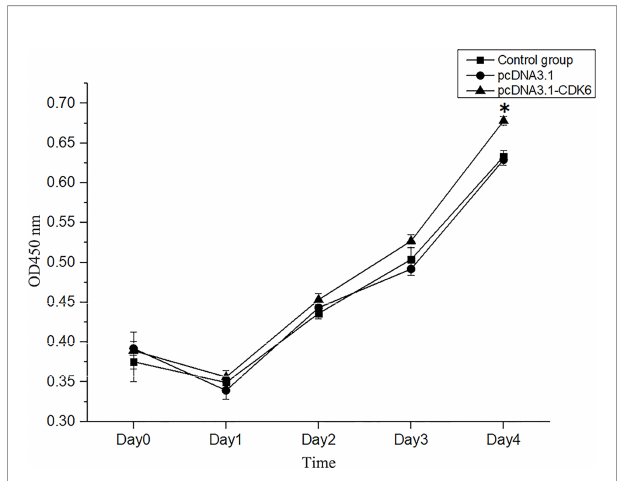
FIGURE 9 | Cell viability assays of transfected and normal H. cumingii mantle cells cultured for 0 d, 1 d, 2 d, 3 d and 4 d. *Indicates a signi fi cant difference.